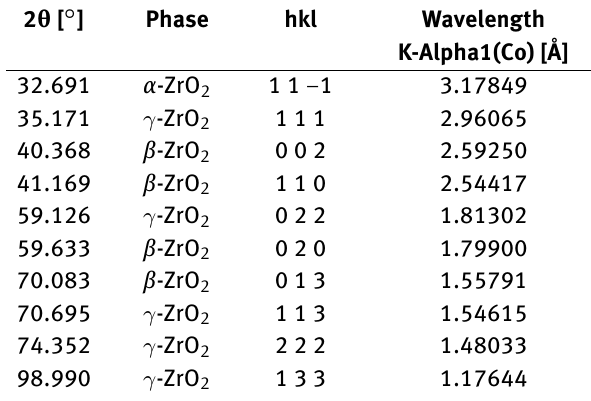
Table 3: Phase composition analysis of the sample after accelerated